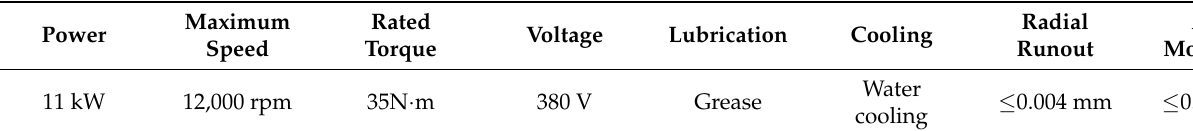
Table 2. The parameters of 212-series motorized spindle.